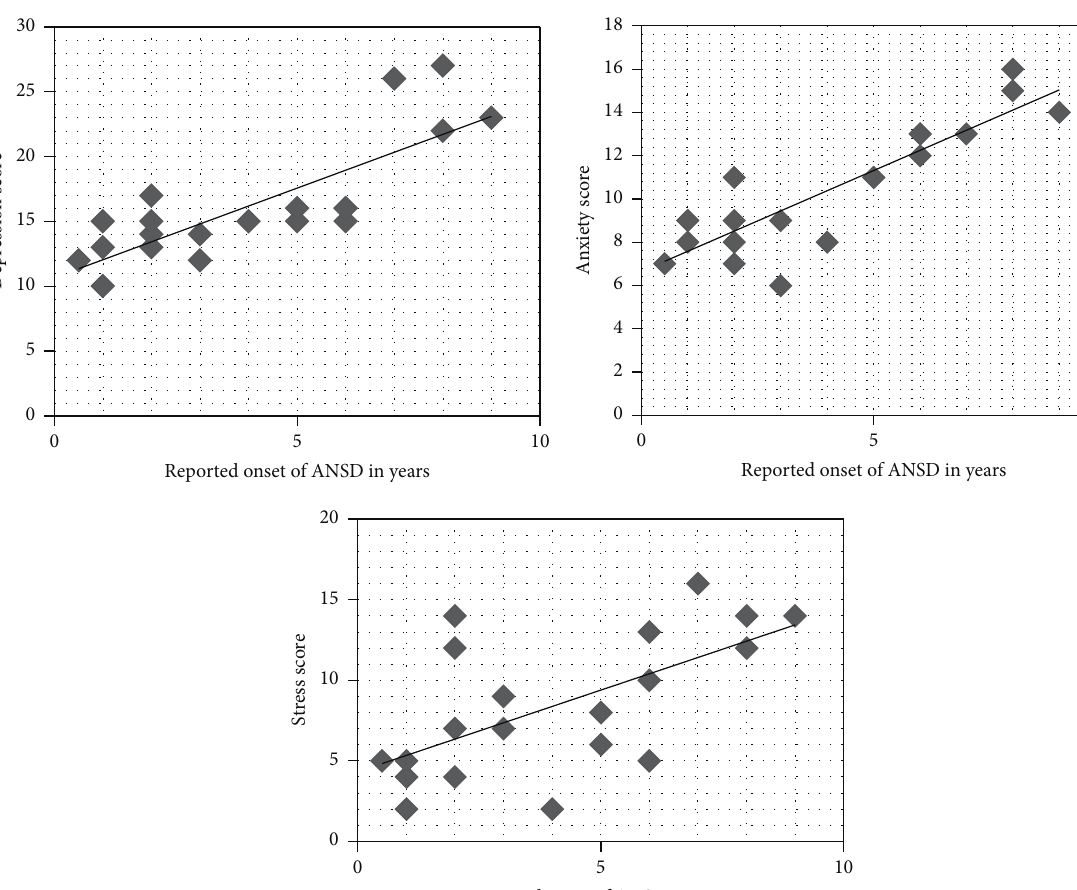
correlation for depression ( 𝜌 = 0.79, 𝑝 < 0.01 ) and anxiety ( 𝜌 = 0.817, 𝑝 < 0.01 ) and a moderate positive correlation for stress ( 𝜌 = 0.631, 𝑝 < 0.01 ) with respect to the reported onset of ANSD. The results on correlation of age of reported onset and DASS scores are shown graphically using scatter plots in Figure